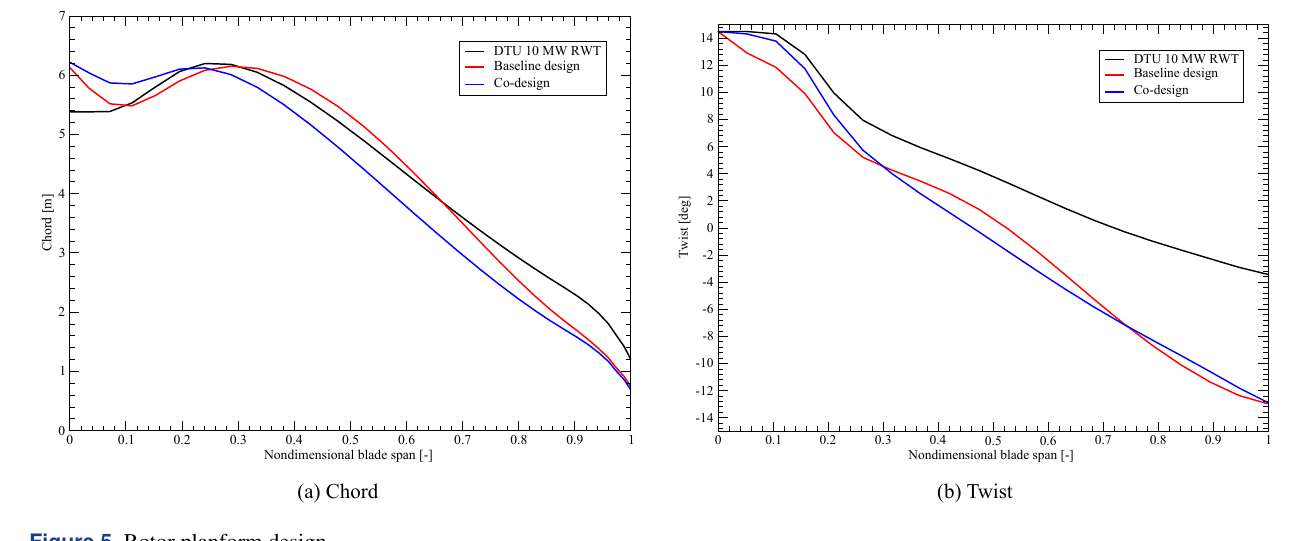
Figure 5. Rotor planform design.